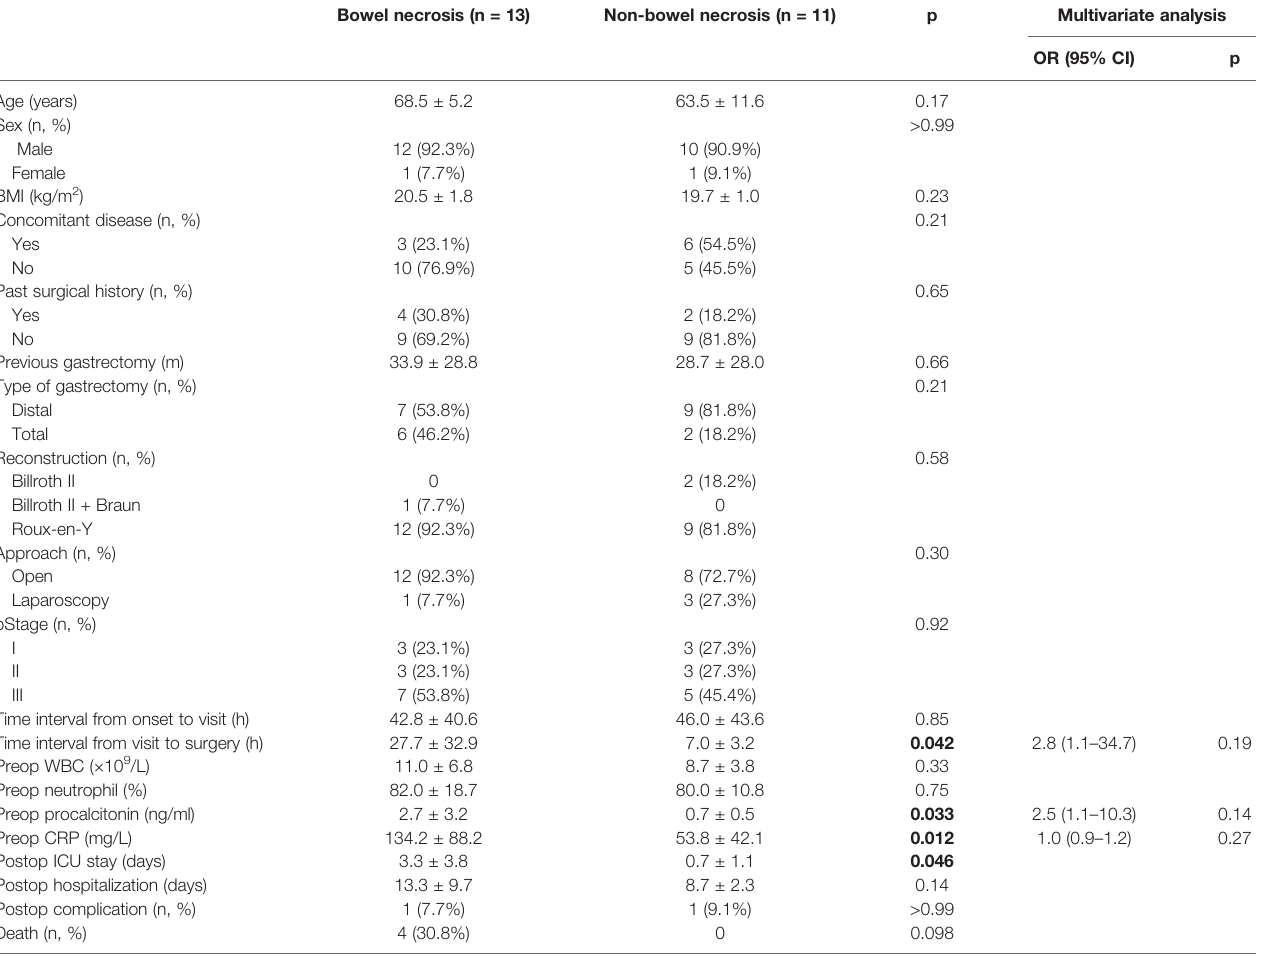
TABLE 3 | Comparison between patients with or without bowel necrosis following Petersen ’ s